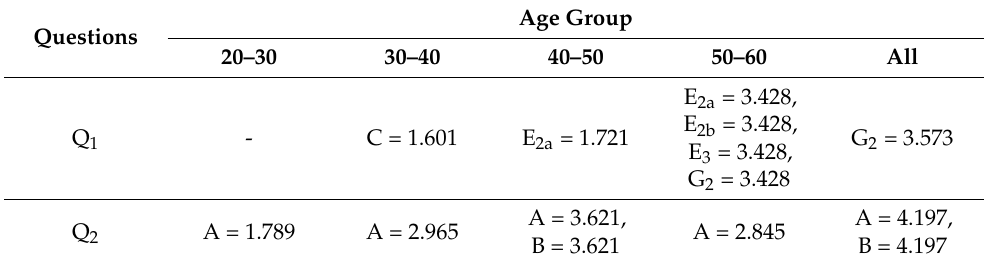
Table 4. Highest values of the information centrality index for the concepts of questions Q 1 and Q 2